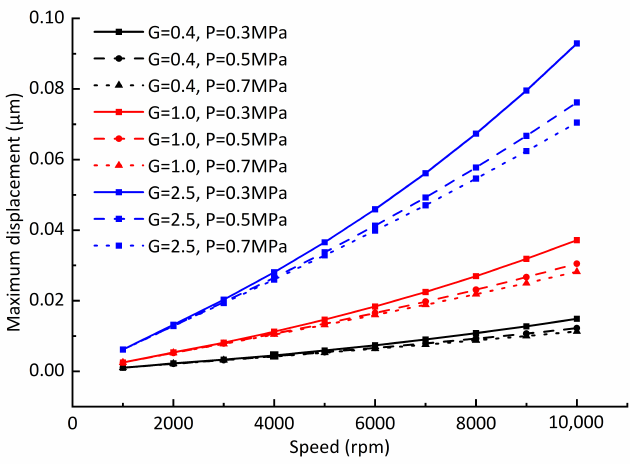
Figure 17. Influence of rotating speed on rotor dynamic equilibrium position offset (gas film gap C 1 = 10 µ